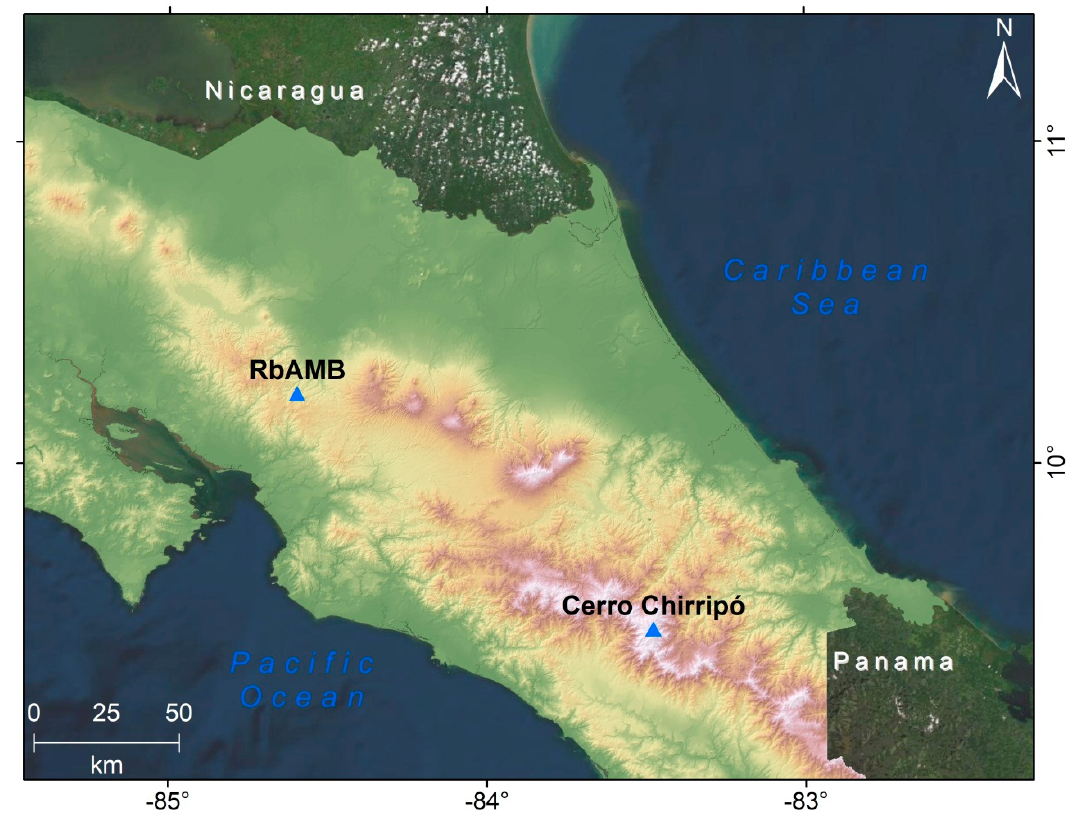
Figure 1. Location map of the study sites: Cerro Chirripó in south-east Costa Rica in the Talamanca Range and RbAMB (Reserva Biológica Alberto Manuel Brenes) in the north-west of the country in the Central Volcanic Range.